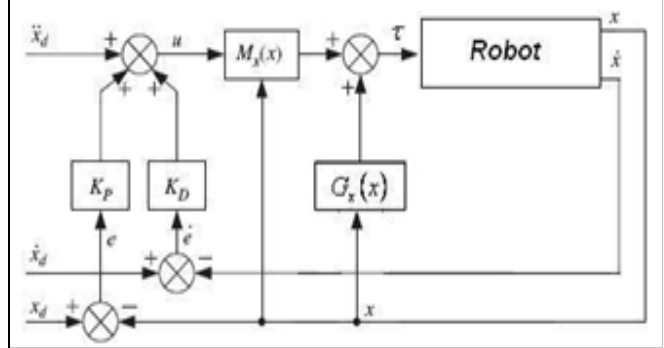
Figura 7: Diagrama en bloques del Esquema de Control por Modelo Dinámico Inverso. Fuente: Autores,